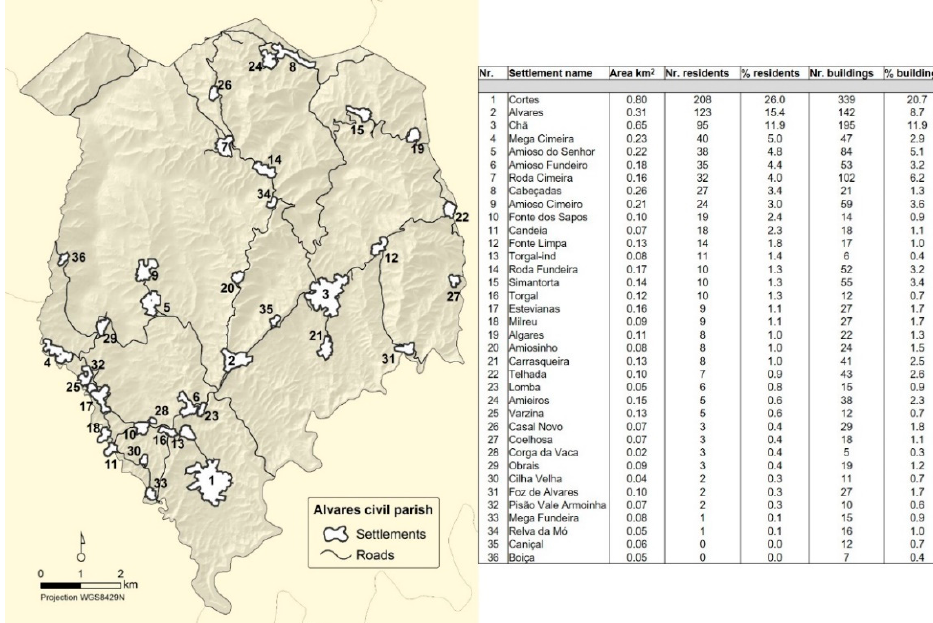
Figure 2. Settlements identified in the civil parish of Alvares and their main characteristics regarding area, residents, and buildings. The settlements are numbered in decreasing order of the number of inhabitants.